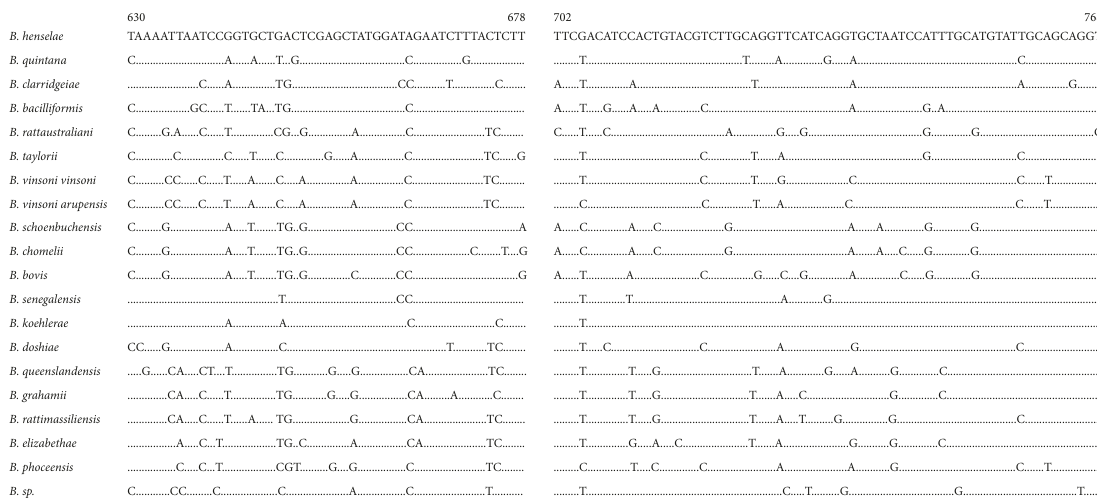
Figure 2: Alignment of oligonucleotides for Bartonella PCR based on gltA used in this study. Two partial amplicons of polymorphic regions of Bartonella spp. based on gltA are shown. The base of B. henselae (L38987.1) shown at the top of the figure was complete with the coding sequences from 630 to 678 and 702 to 768. Dots indicate identical nucleotide sequence to that of B. henselae . Through the polymorphic region of Bartonella spp., different Bartonella species could be determined by genomic sequencing in this study. The number of nucleotide mismatches between B. henselae and other Bartonella species in the 116 polymorphic coding sequences is also noted (mismatch in coding sequences from 630 to 678 and 702 to 768 with about 5 and 23 nucleotides). In this polymorphic region, none of Babesia species had identical (Figure 3). Based on these alignments, phylogenetic trees were constructed by the maximum likelihood and Bayesian inference method using MEGA 6.0. Bootstrap values were calculated using 500 replicates.